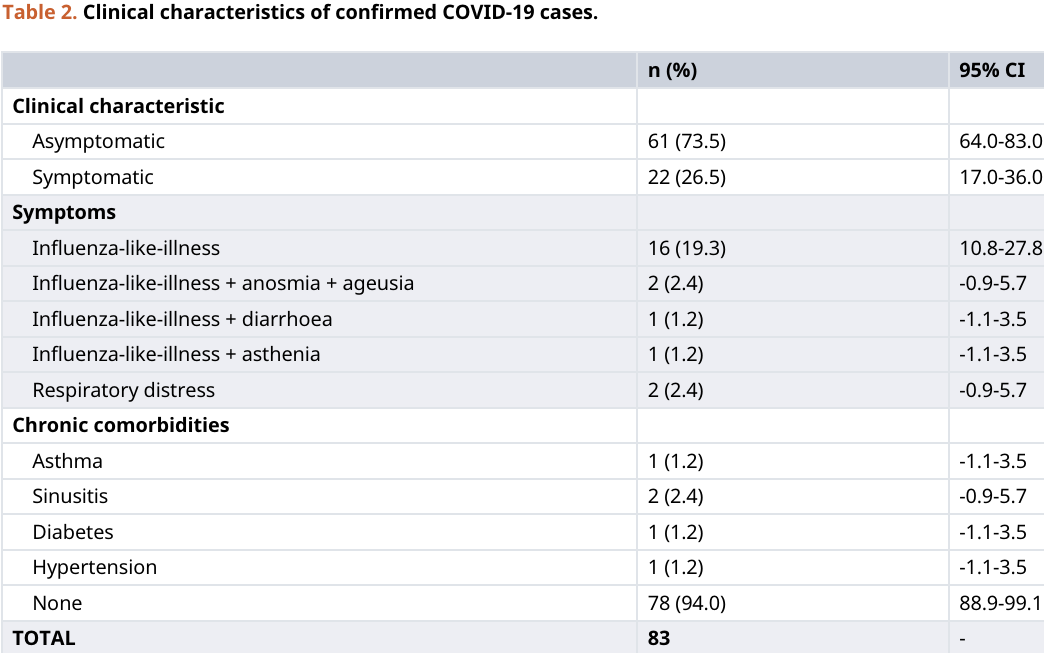
Table 2. Clinical characteristics of confirmed COVID-19